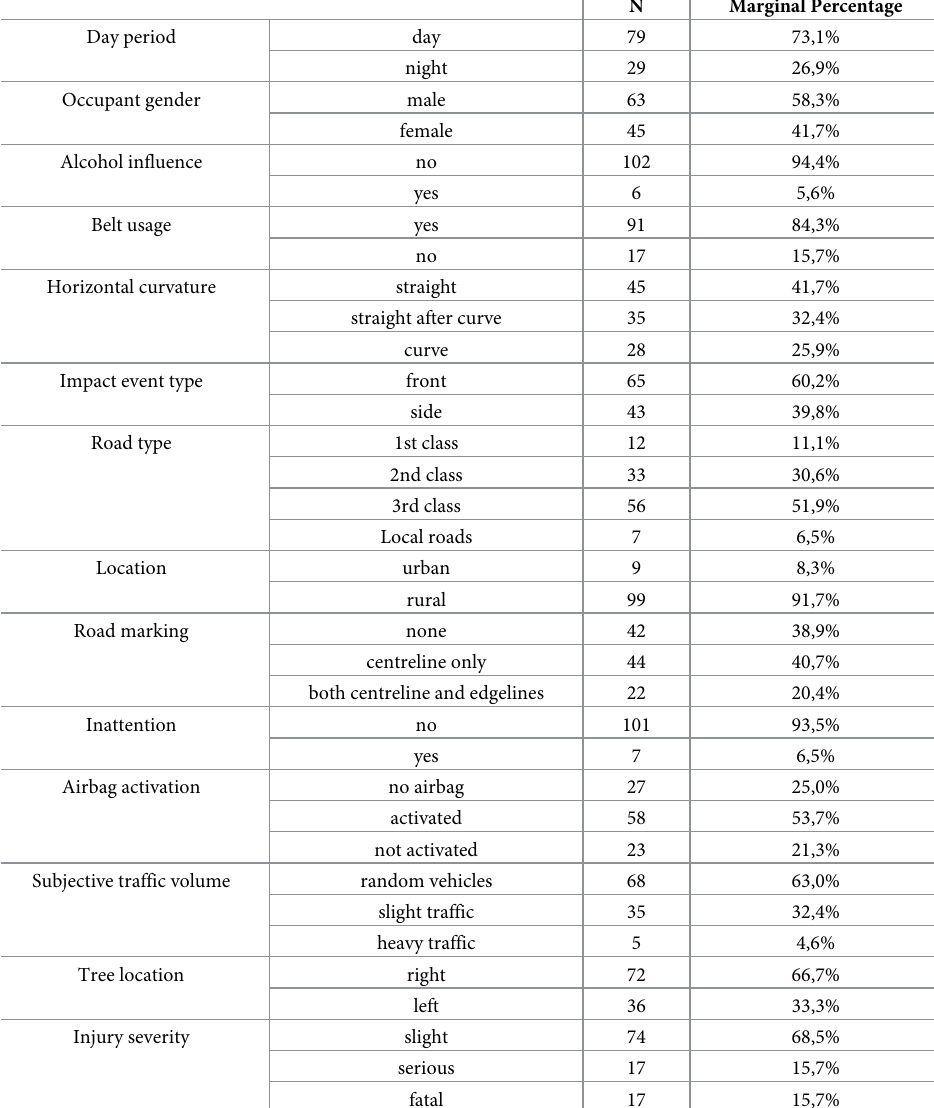
Table 3. Summary of categorical